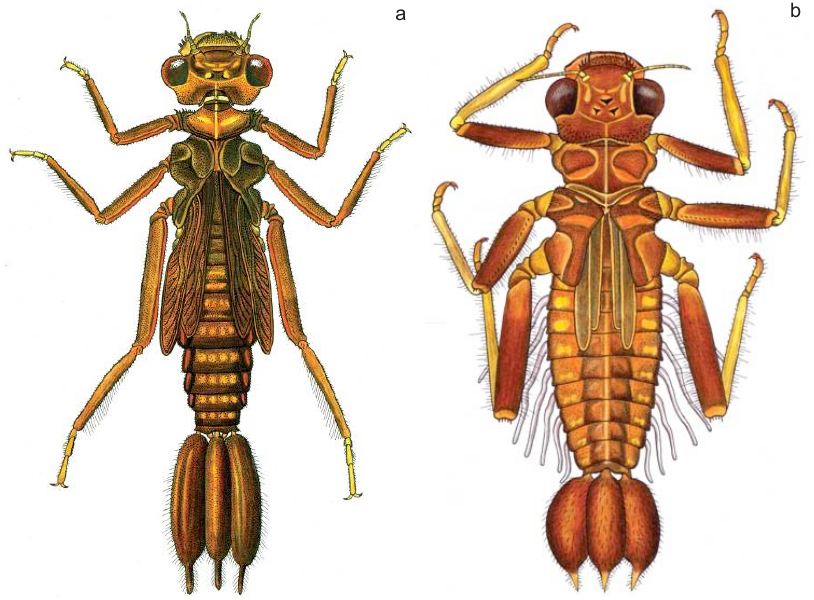
Figure 6. Chlorocyphidae [fig. taken from Fraser 1919a (fig. No. XXIII),